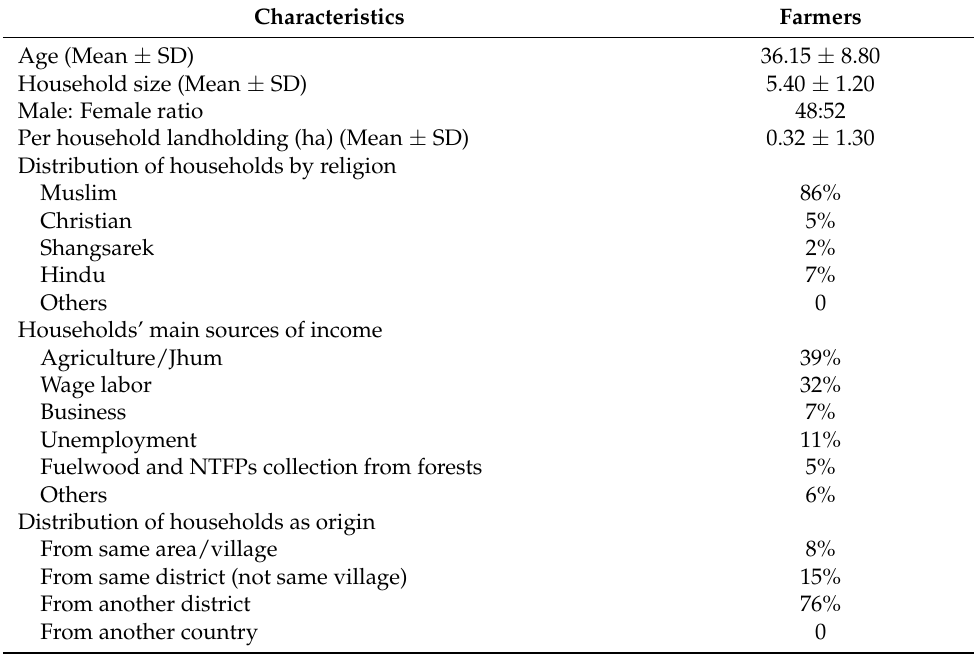
Table 2. Demographic characteristics of the agroforestry farmers living in Madhupur Garh.